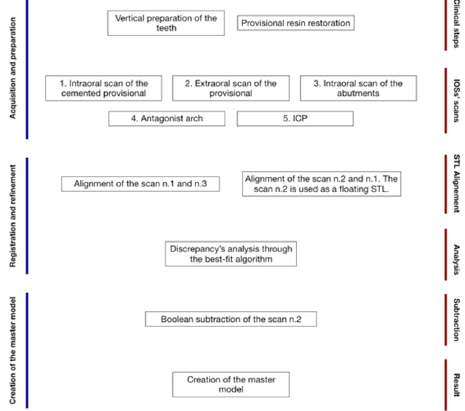
Figure 1. Schematic of the protocol of Agustín-Panadero et al.